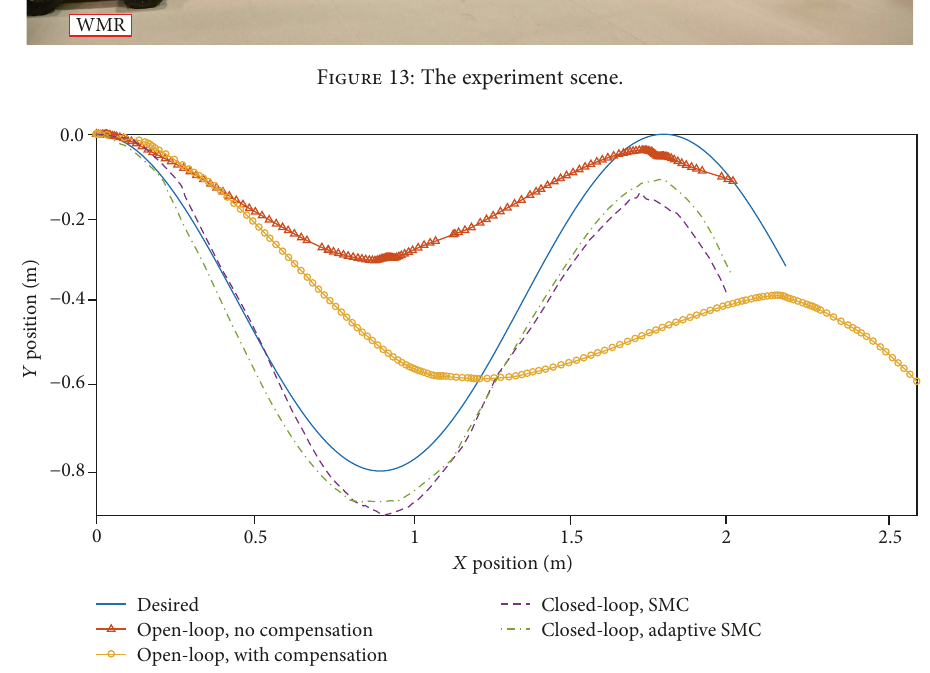
Figure 14: The comparison of position changes.